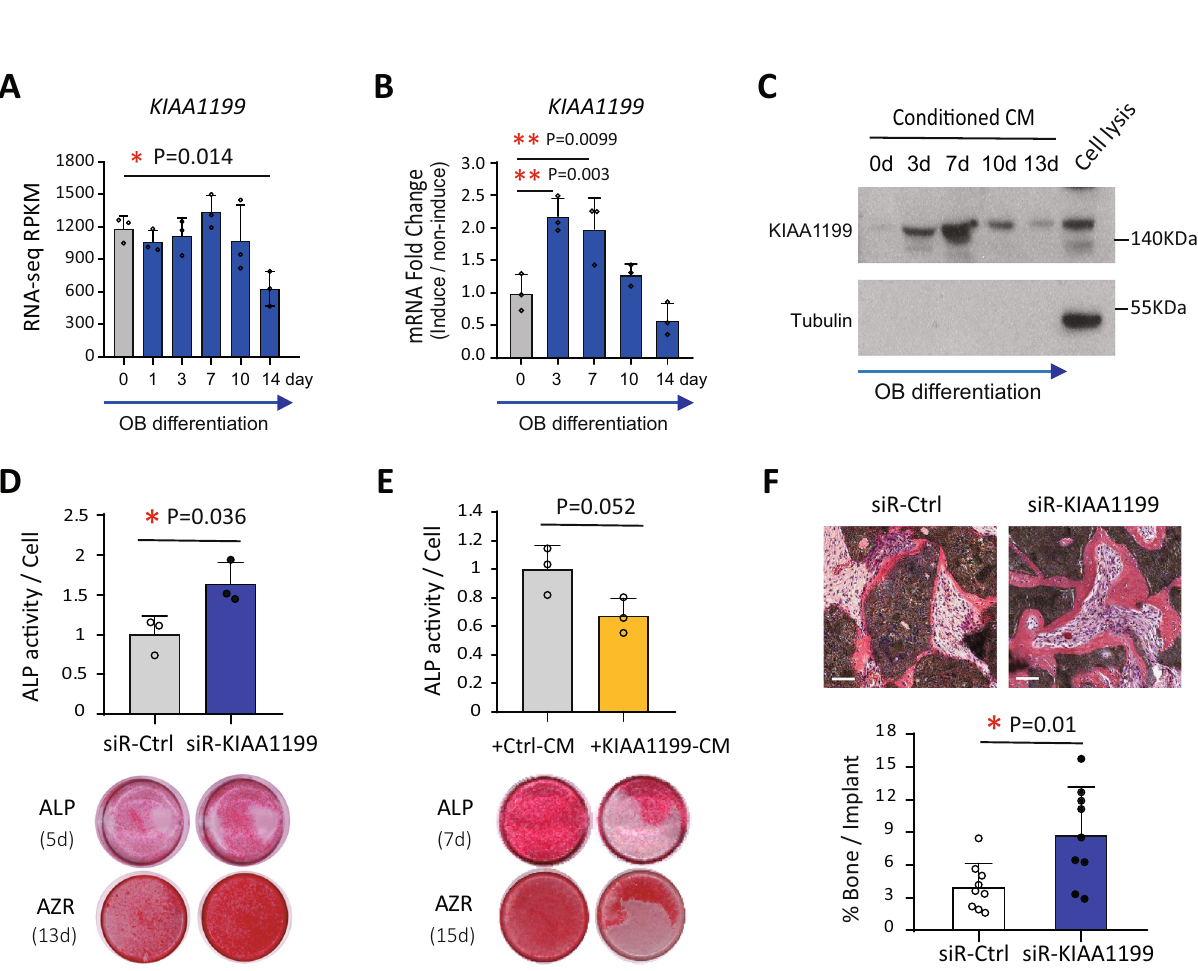
Fig. 2 | KIAA1199 is a regulator of osteoblast differentiation of human bone marrow stromal stem cells (hBMSC) in vitro and bone formation in